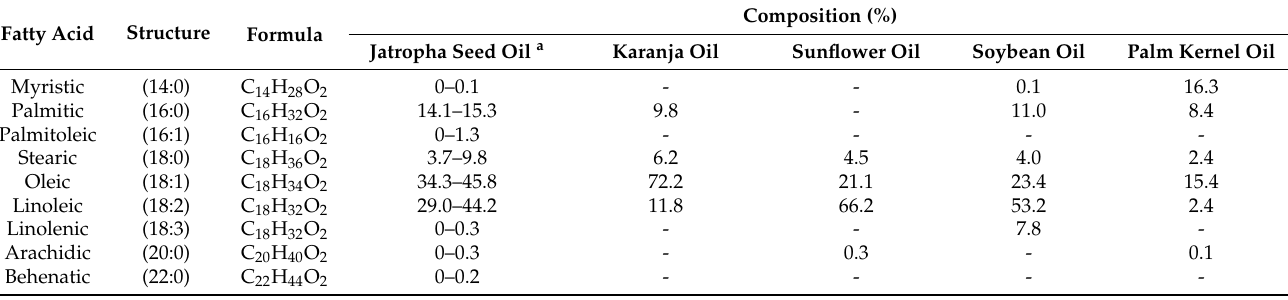
Table 5. Fatty acid composition (%) of different vegetable oils. This information is adapted from Koh and Ghazi [126]. Fatty Acid